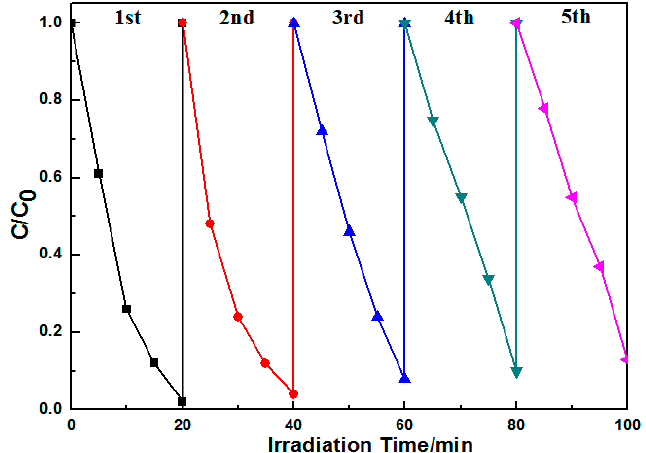
Figure 10. Cycling runs for the photocatalytic degradation of MB in the presence of Ag@AgCl (10 wt %)/Bi 2 O 2 CO 3 composite under visible light irradiation.